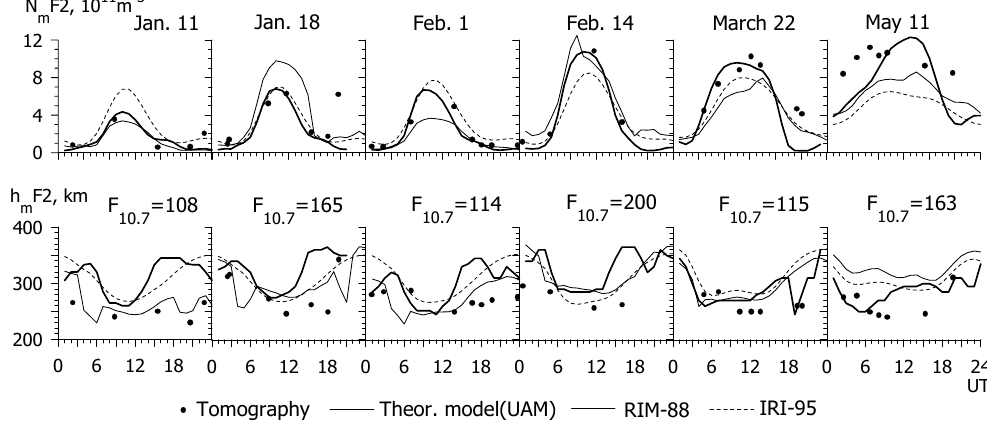
Fig. 10. Diurnal variations of Nm F2 and hm F2 at 67 ◦ N, 33 ◦ E in January–May 1999 from tomography and model calculation data.